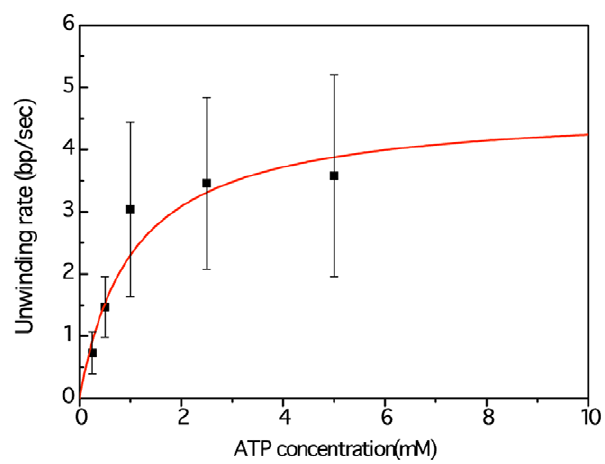
Figure 4. ATP dependence of unwinding velocities of Gk DnaC WT obtained from smTPM. Helicase unwinding velocities were measured at different ATP concentrations (0.25–5.0 mM). The data were fitted to Michaelis-Menten kinetics, yielding K M, ATP of 1.03 6 0.46 mM and V max of 4.69 6 2.00 bp/s.